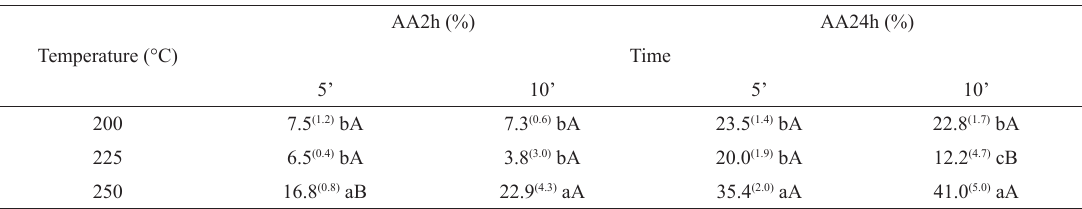
Table 4: Deployments of average values of water absorption after two and twenty-four hours based on the time and temperature of MDF.